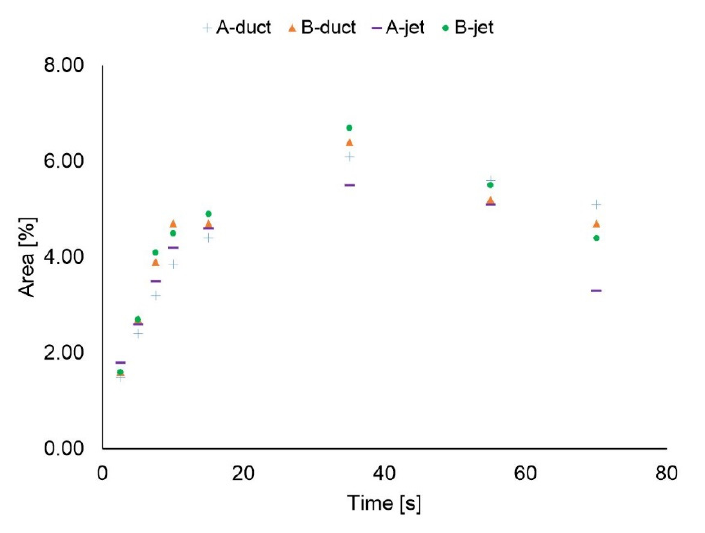
Figure 21. Comparison of both analyzed systems. Blue plus sign presents A source of leakage for duct ventilation; Orange triangle presents B source of leakage for duct ventilation; Purple minus sign presents A source of leakage for jet ventilation; Green circle presents B source of leakage for jet ventilation.